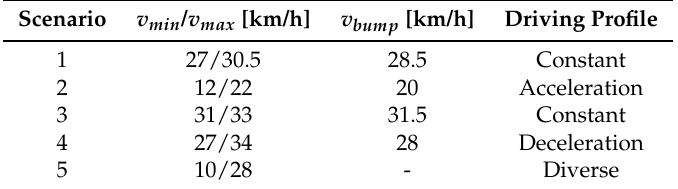
Table 5. Key velocities of 5 road bump scenarios for the vehicle model validation.